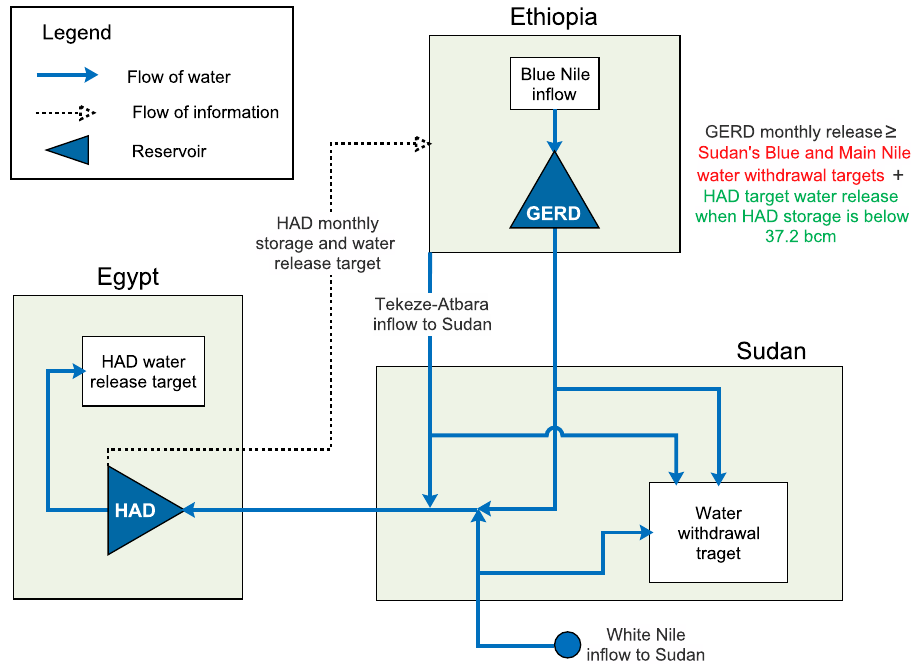
Fig. 2 Illustration of the coordinated strategy for operating the Grand Ethiopian Renaissance Dam. HAD High Aswan Dam, GERD Grand Ethiopian Renaissance Dam. A detailed schematic of the river system model is provided in Supplementary Figure